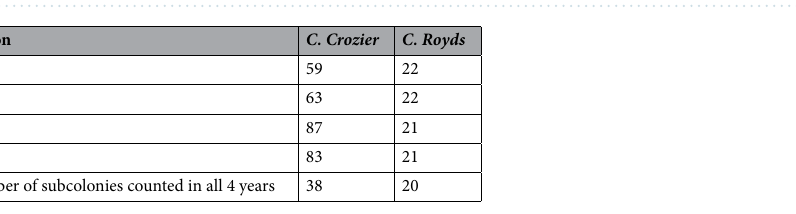
Figure 1. Study areas on Ross Island, Antarctica. The star on the inset map of Antarctica indicates the area of detail. Yellow polygons show all subcolonies at Cape Crozier and Cape Royds, blue polygons indicate the subcolonies used in this study to model reproductive success. Satellite image of Cape Crozier from WorldView-3, November 20, 2014 (copyright 2014 DigitalGlobe, NextView License) and of Cape Royds from WorldView-2 November 27, 2015 (copyright 2015 DigitalGlobe, NextView License). Base satellite image of Ross Island vicinity acquired by the Moderate Resolution Imaging Spectroradiometer (MODIS) on board the Aqua satellite on November 29, 2011 (courtesy of Rapid Response Imagery from the Land, Atmosphere Near real- time Capability for Earth Observing System operated by the NASA/GSFC/Earth Science Data and Information System with funding provided by NASA/HQ).